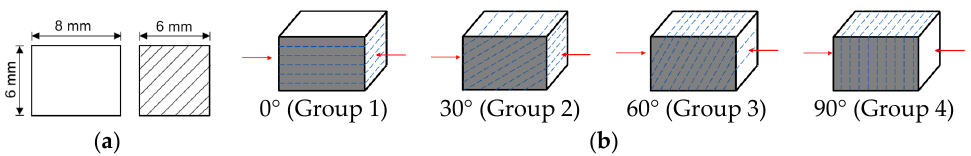
Figure 1. Preparation of the shale cuboid specimens for the in situ uniaxial compression experiments: ( a ) Schematic diagram of the specimen and ( b ) 4 testing groups with different angles between loading direction and bedding plane.